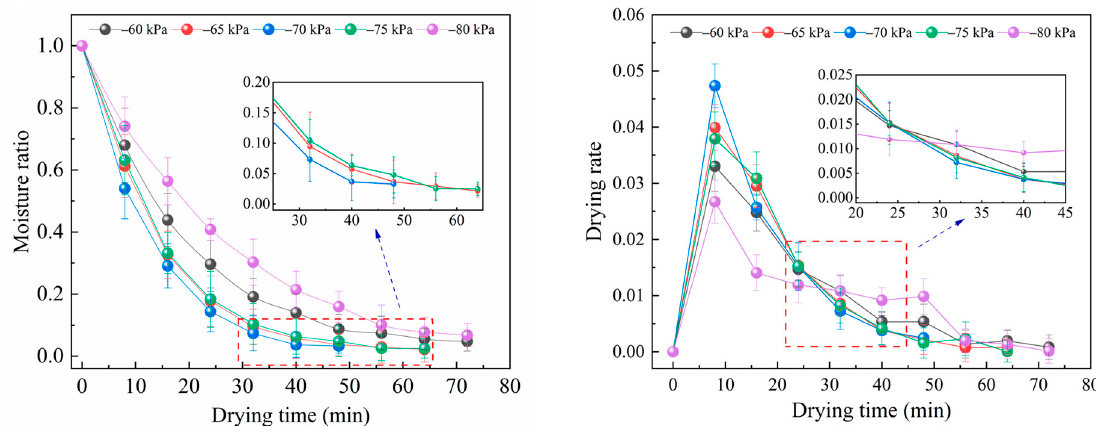
Figure 4. Effects of vacuum degree on drying curve and drying rate